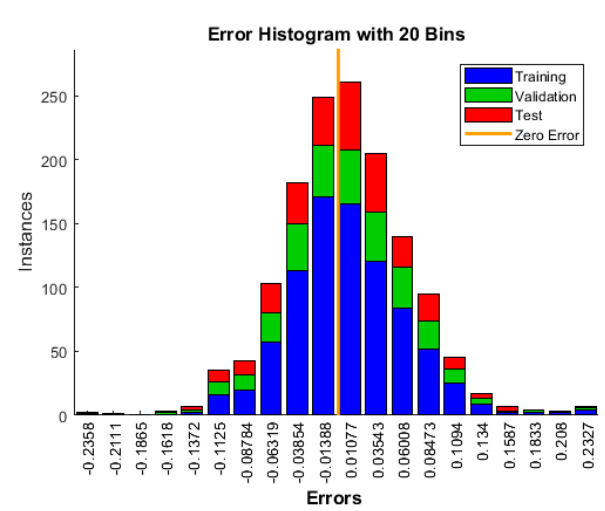
Figure 11. Error histograms obtained during the learning process for the best analyzed neural network.